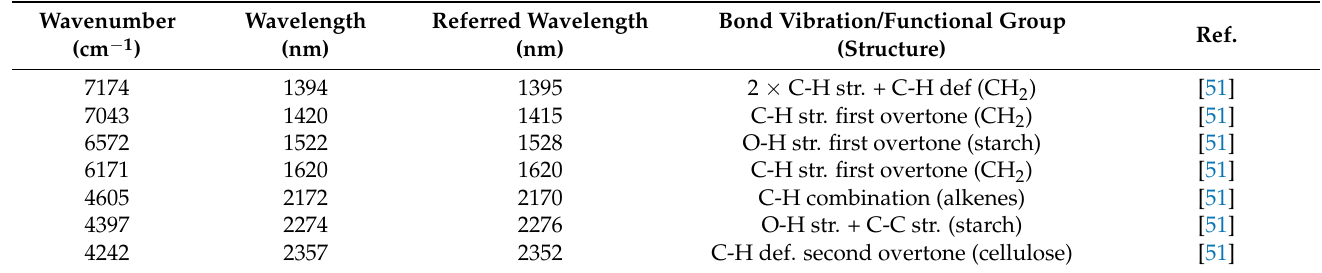
Table 12. The bands with a high-regression coefficient of the PLSR model for TSS in mangosteen pur é